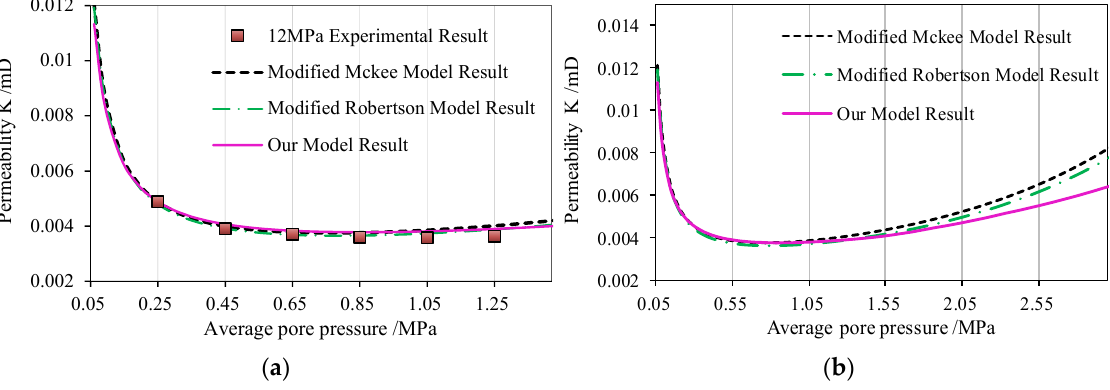
Figure 13. Calculation results of the permeability models under a hydrostatic stress of 12 MPa and the corresponding experimental data of sample M3. ( a ) Comparison of the permeability models with experimental data. ( b ) Calculation results for a wider pore pressure range.